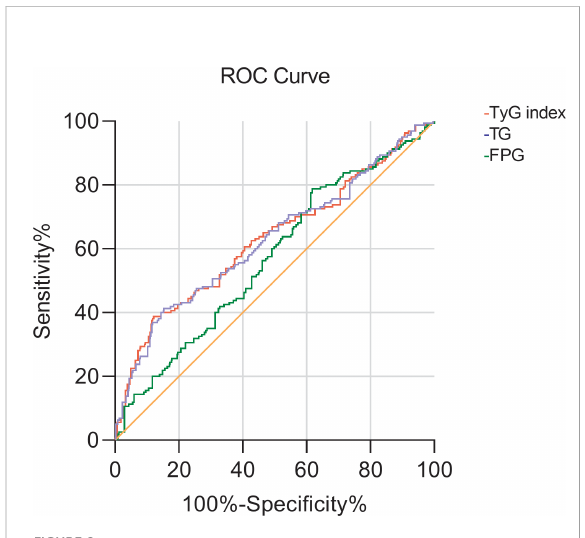
FIGURE 2 The ROC curve of TG, FBG, and TyG index for early renal impairment (CysC>1.25mg/L) in patients with